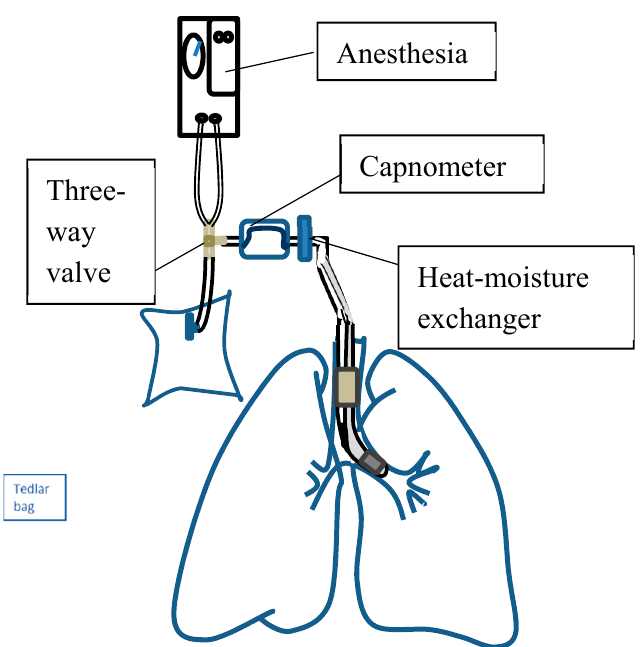
Figure 1. Schematic of the system framework and sample collection.